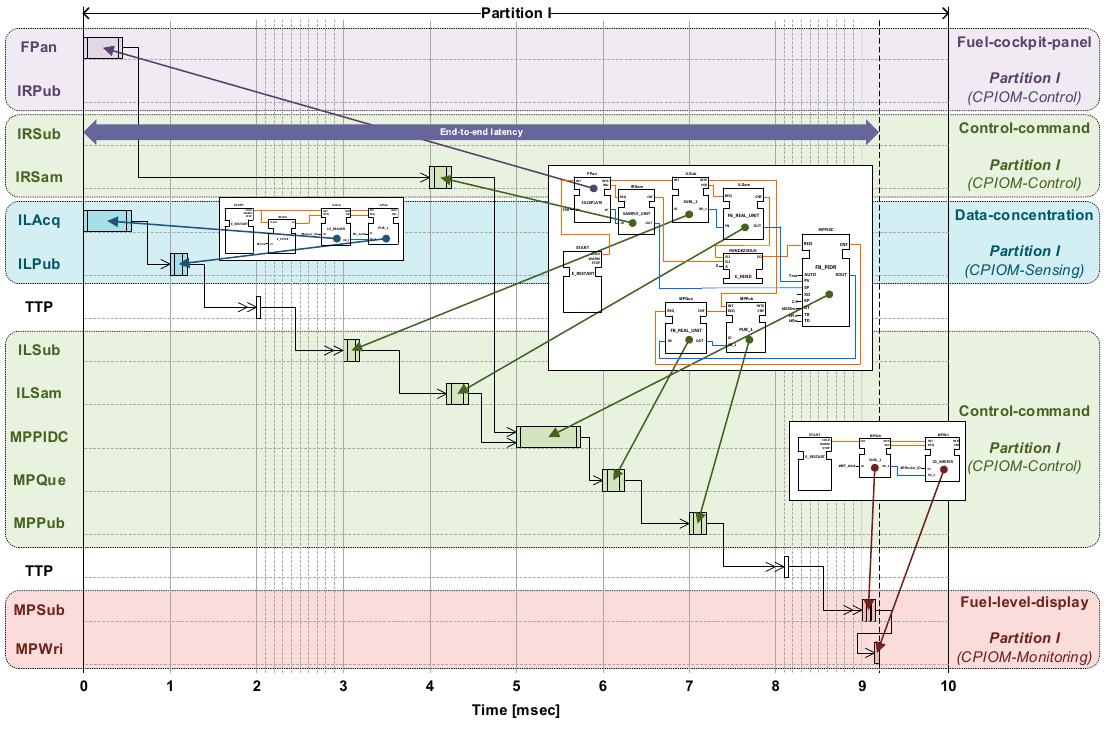
Figure 15. Scheduling strategy 1a of the FBs for the Inner Transfer Tank (ITT) control.